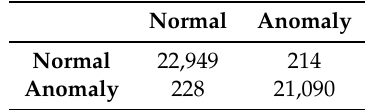
Table 33. Confusion matrix for Bagging J48.